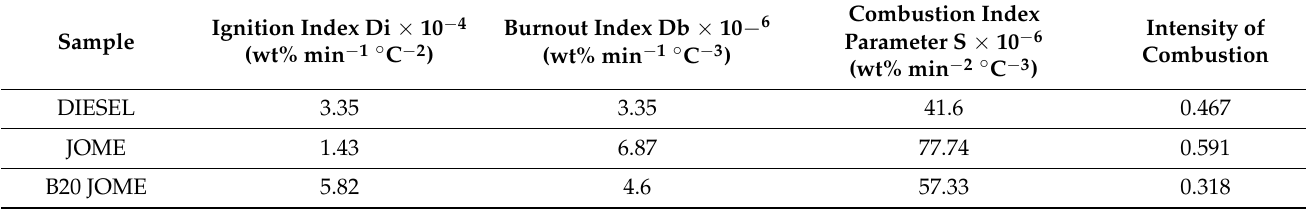
Table 7. Combustion characteristics of diesel, JOME, and B20